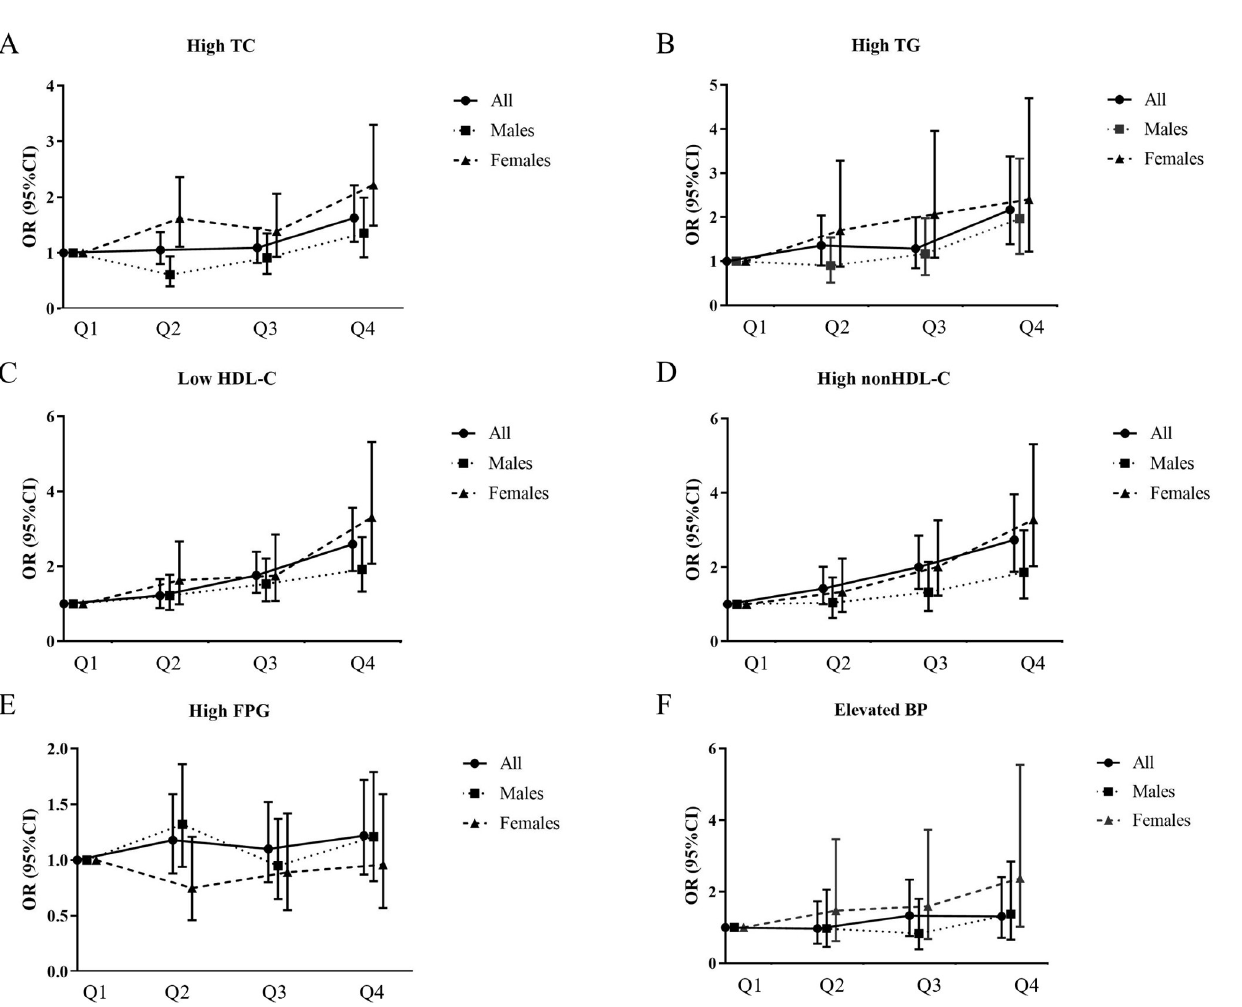
Fig 3. Adjusted OR and 95%CI for quartiles SUA and metabolic abnormalities in US adolescents 2001–2018, stratified by sex. Analyses were adjusted for age, gender (not for adjusted in stratified analysis), race, PIR, TV time, computer time, BMIZ, WHtR and eGFR. In all, serum uric acid (mg/dl) quartiles were defined as follows: quartile 1 < 4.2; quartile 2 4.2–4.9; quartile 3 5.0–5.8; quartile 4 > 5.8. In males, serum uric acid (mg/dl) quartiles were defined as follows: quartile 1 < 4.9; quartile 2 4.9–5.5; quartile 3 5.6–6.3; quartile 4 > 6.3. In females, serum uric acid (mg/dl) quartiles were defined as follows: quartile 1 <